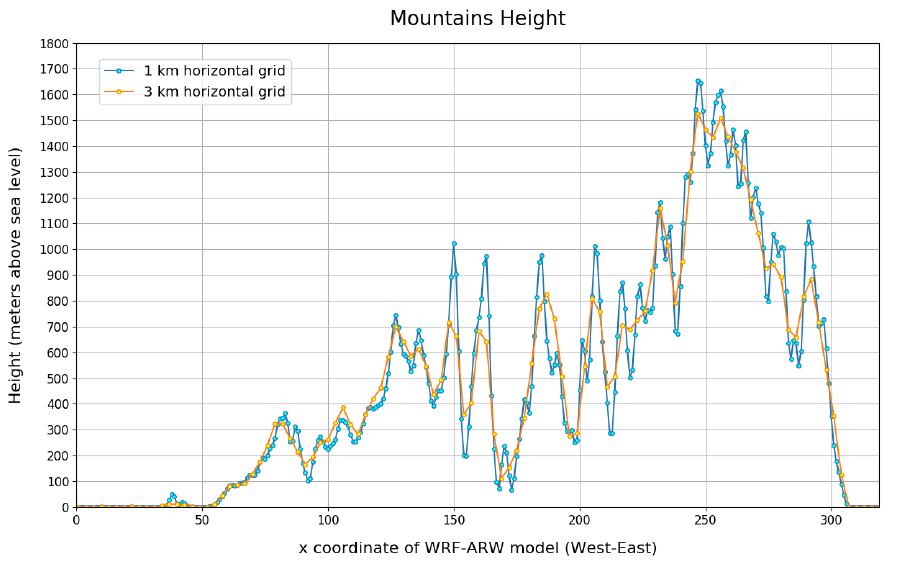
Figure 6. Height of the northern mountains of Sicily above the sea level obtained by perform- ing an horizontal cross correlation. The comparison between the domains of 3 km and 1 km is explicitly